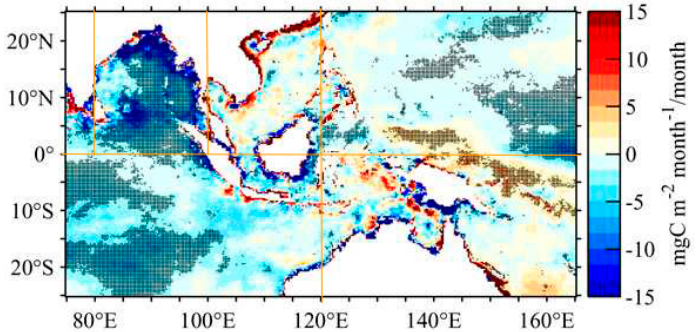
Figure 5. Long-term NPP trend during the period of 1998–2016. Points plotted are the statistically significant values (p < 0.1).